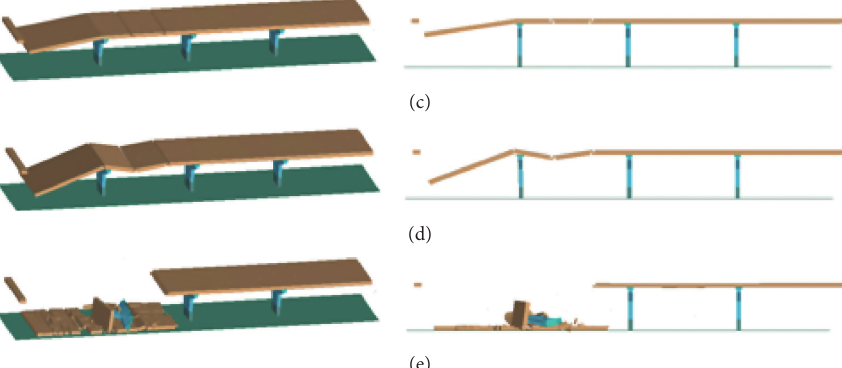
Figure 19: Collapse response of Hongqi Bridge in the case of two hinge in the second span: (a) t � 0.00s, (b) t � 0.10s, (c) t � 0.68s, (d) t � 1.40 s, (e) t � 1.56s.